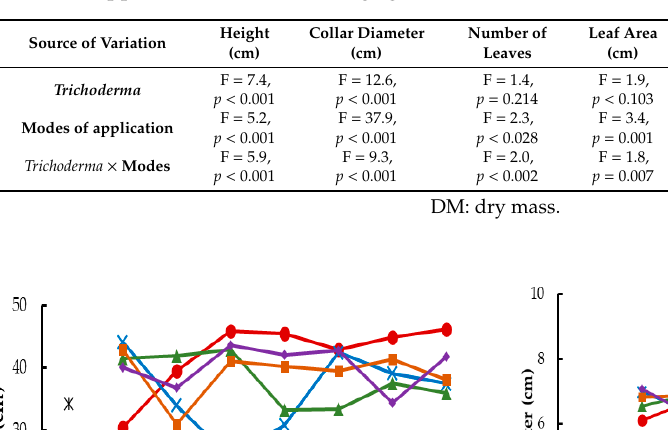
Table 2. Results of repeated measures ANOVA two-way testing the effect of isolates of Trichoderma and modes of application on açaí seedlings growth.